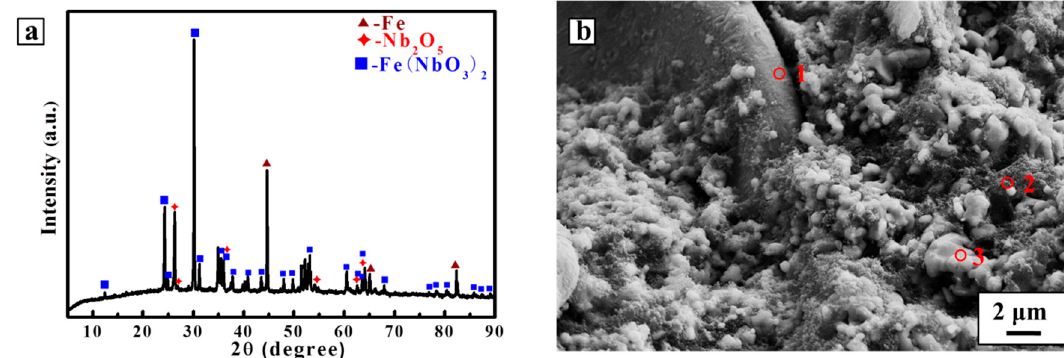
Figure 1. ( a ) X-ray diffractometer (XRD) pattern and ( b ) scanning electron microscope (SEM) image of the Nb 2 O 5 /Fe/C composite pellet sintered at 1000 °C for 3 h. Table 1. Energy-dispersive X-ray (EDS) analyses of Point 1, Point 2, and Point 3 marked in Figure 1b. Point Elementary Distribution (at Point